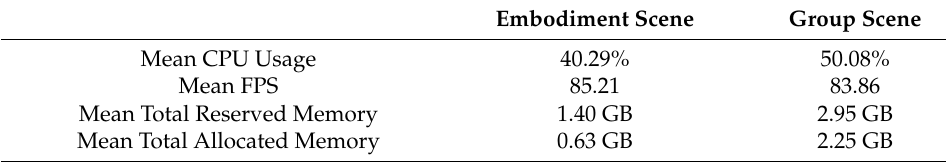
Table A10. Mean results for Test Condition